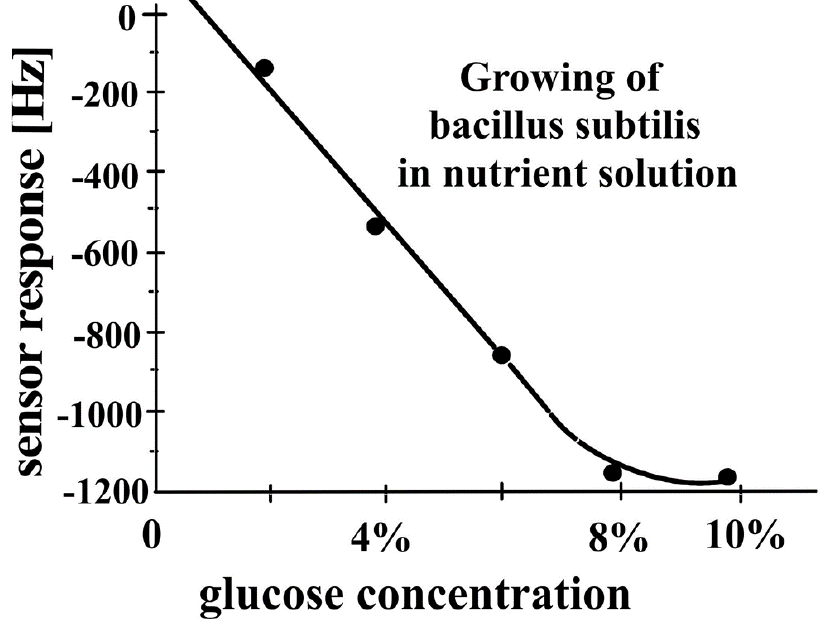
Figure 6. Monitoring the growth of B. subtilis from its spores in nutrient solution as a function of glucose concentration.